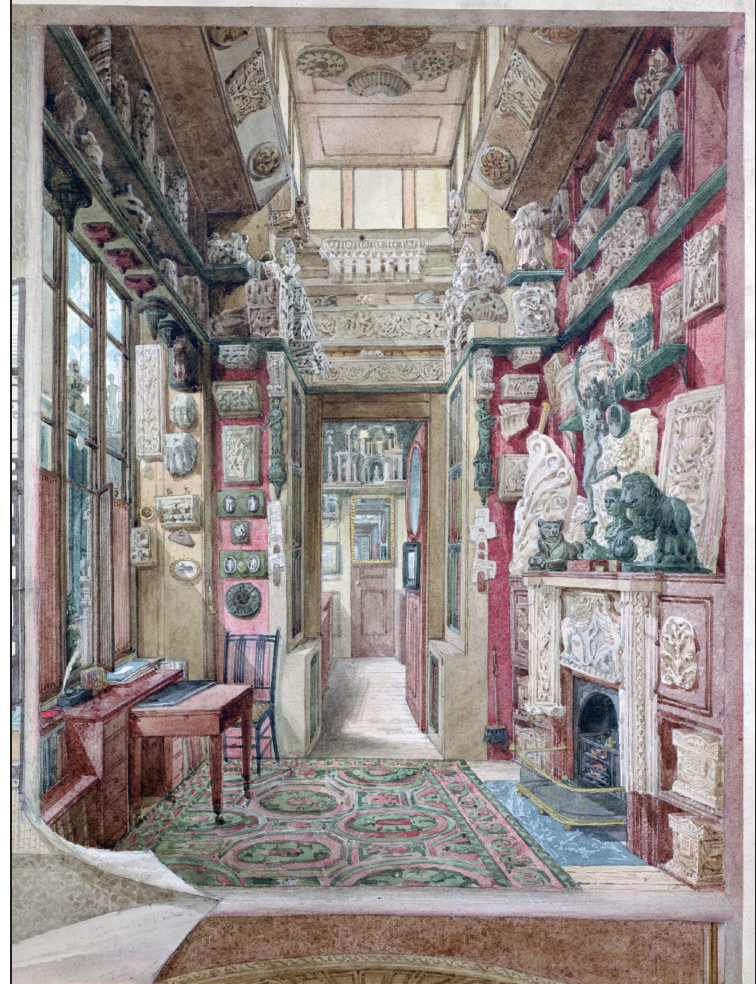
Fig. 10 : Joseph Michael Gandy, View of Soane’s study, 1822, detail from a composite watercolour of views of 13 Lincoln’s Inn Fields, Sir John Soane’s Museum SM